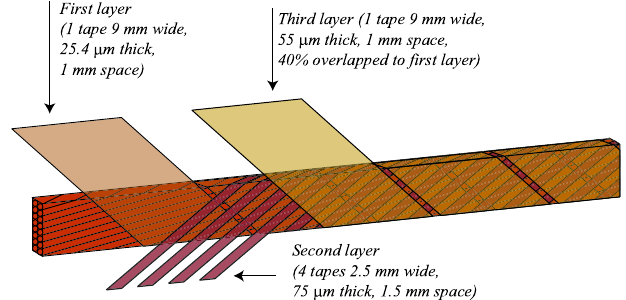
FIG. 10. (Color) Enhanced insulation scheme. Overlap is present between the first and the third layer.